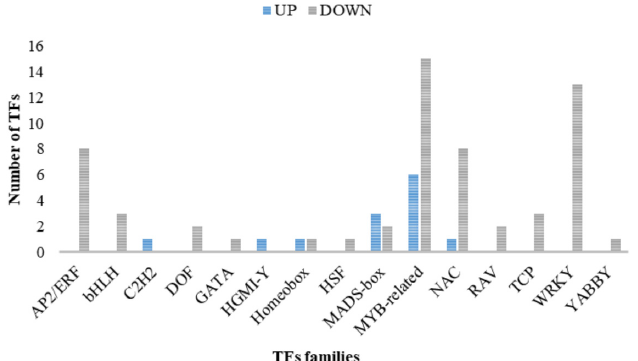
Figure 5. Analysis of di ff erentially expressed transcription factors (TFs) in the epidermis of prickle-free plants in comparison to prickled plants. A total of 75 di ff erentially expressed genes (DEGs) belonging to 15 TF families were identified.